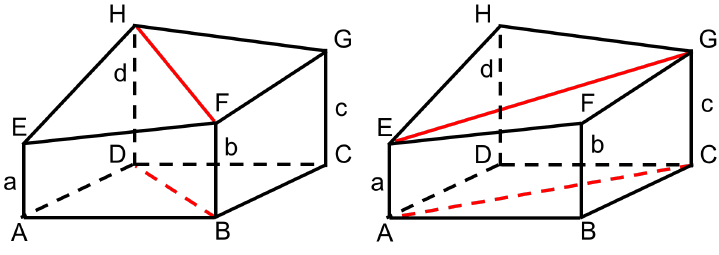
Figure 3. Possible subdivisions of the solid representation of square portion of beach in two